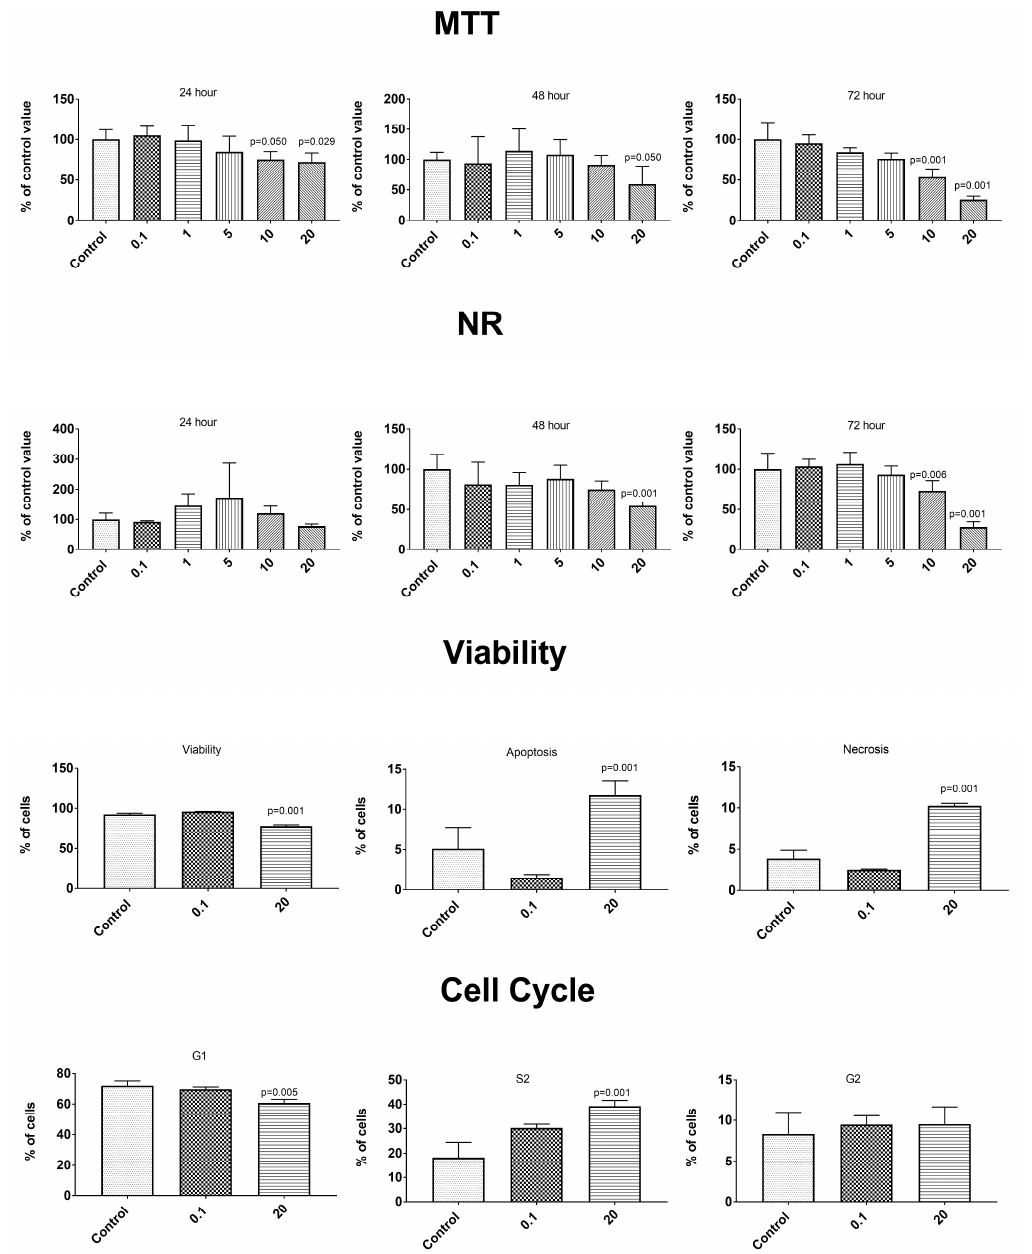
Figure 4. Impact of JA-GD (sample after the in vitro digestion of the JA-elicited lovage leaves) on cytotoxicity (MTT and NR method), type of cell death (Annex V and PI test), and phases of the cell cycle in the HPrEC ATCC ® PCS-440-010™ cell line.